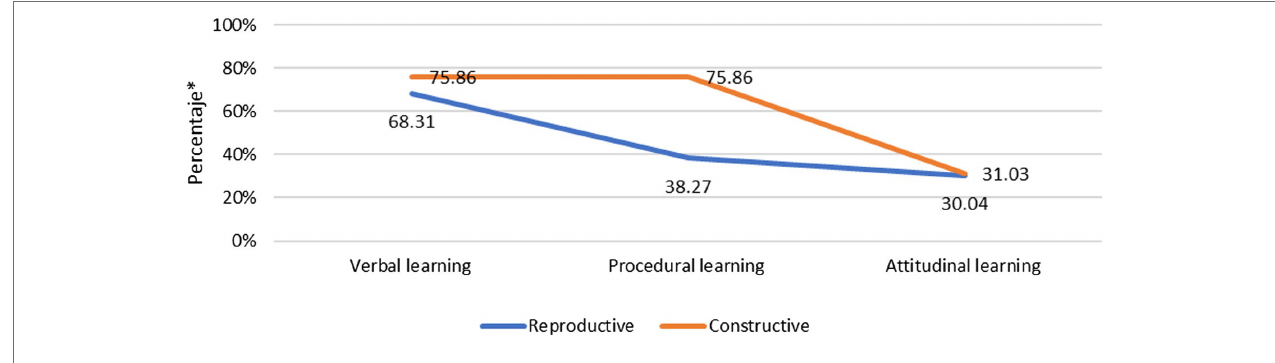
FIGURE 3 | Frequency of each learning worked on in each